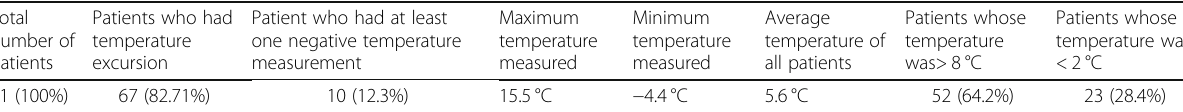
Table 2 Patient proportion according to temperature measurements Total number of patients